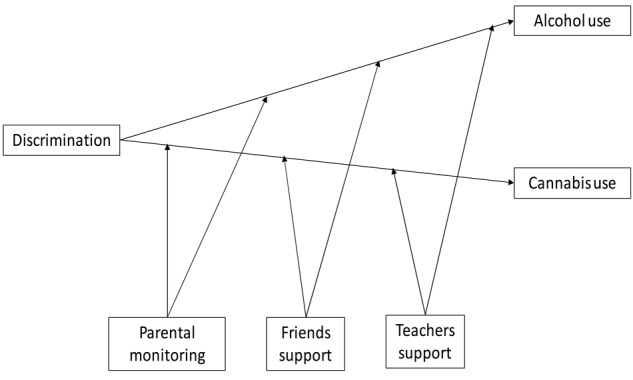
Conceptual model.